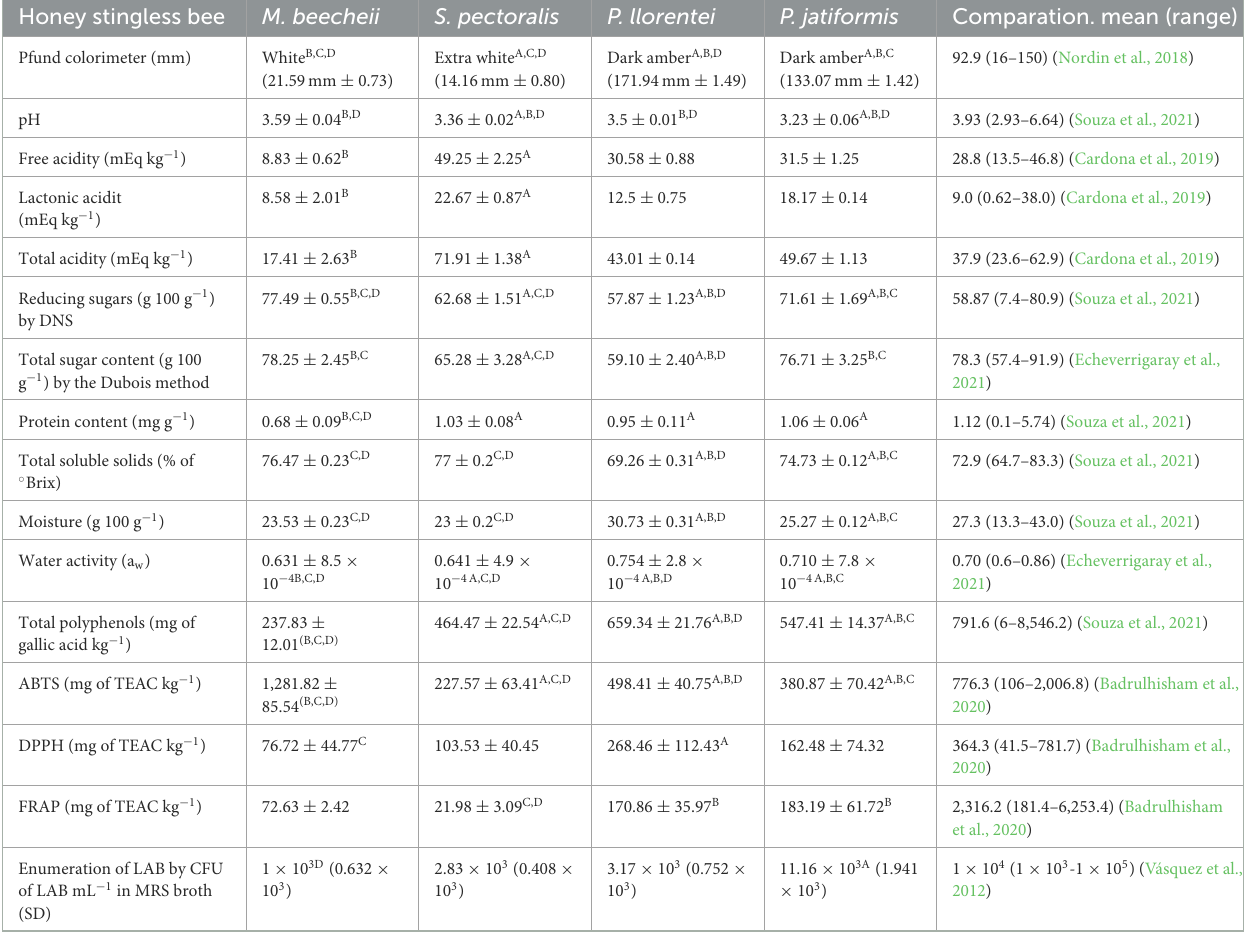
TABLE 1 Physicochemical characterization of the honey produced by stingless honeybees: Melipona beecheii , Scaptotrigona pectoralis , Plebeia llorentei, and Plebeia jatiformis . Honey stingless